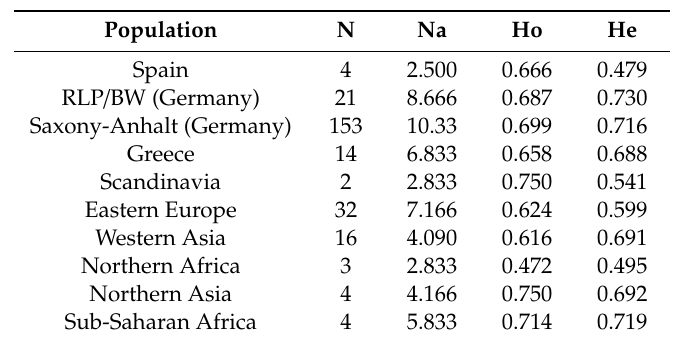
Table 4. Population size (N), the average number of alleles per locus (Na), observed heterozygosity (Ho) and expected heterozygosity (He) at six microsatellite loci in the European bee-eater.